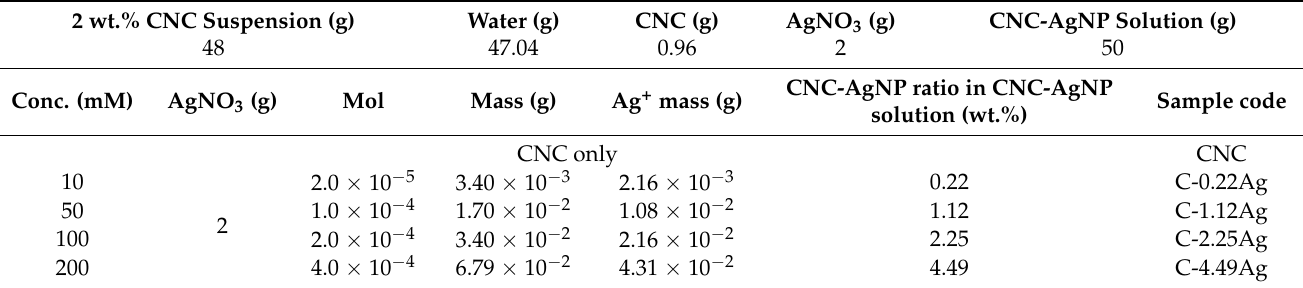
Table 1. Nominal weight ratio of AgNPs in CNC-AgNP